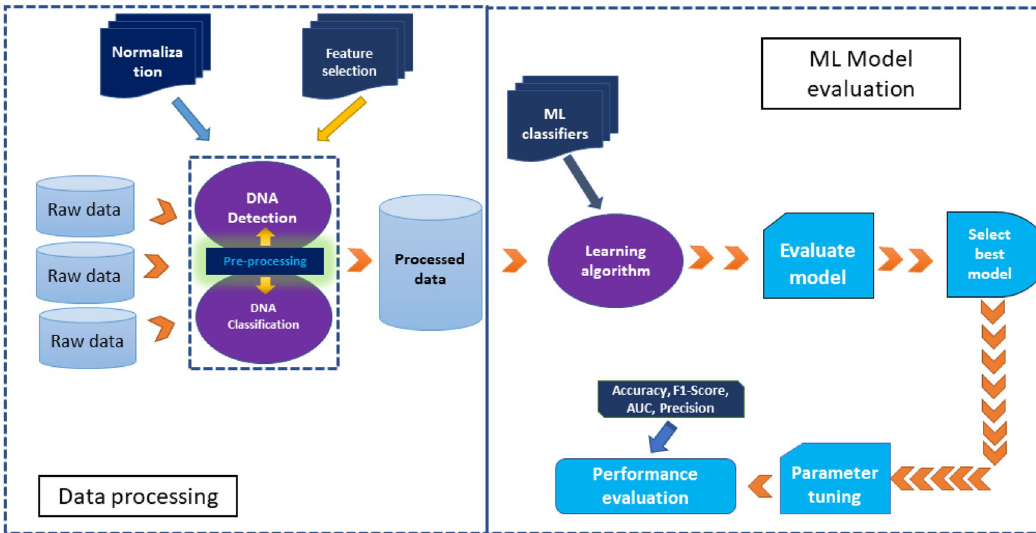
Figure 2. A flowchart of present